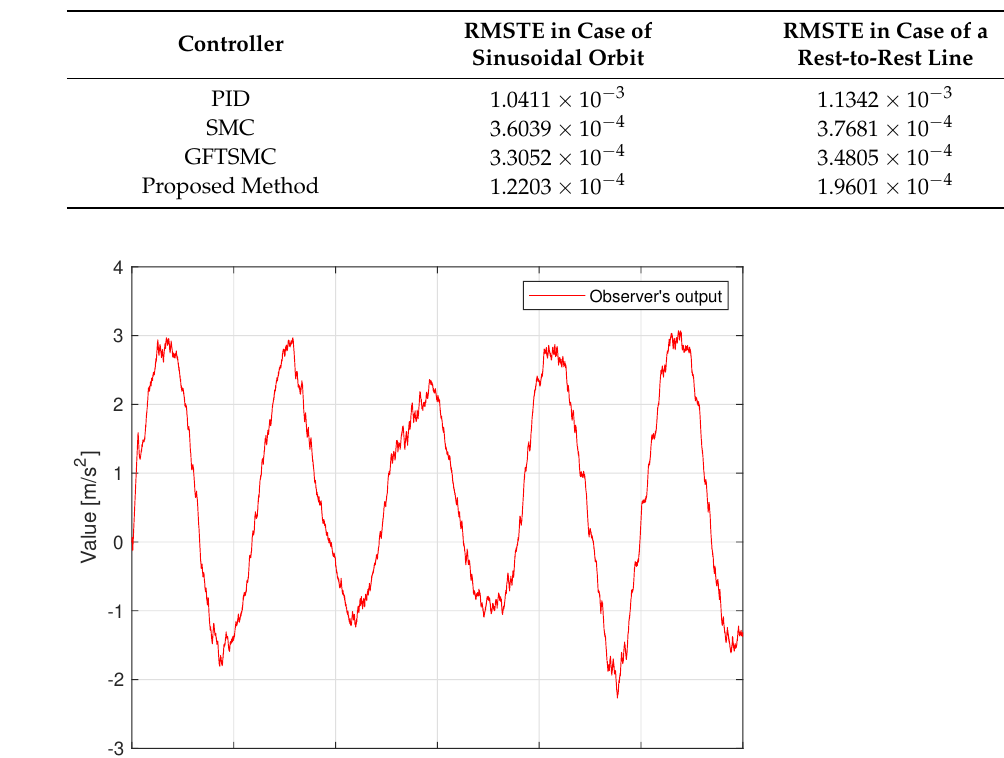
Table 4. RMSTE of four controllers.